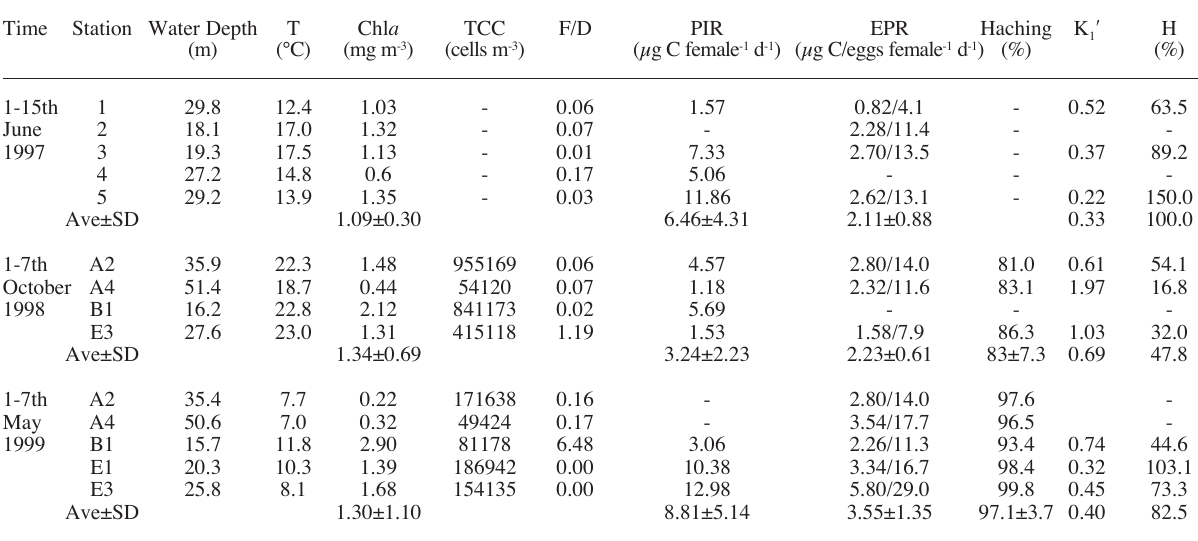
T ABLE 1.- Pigment ingestion rate, egg production rate, hatching success, egg production efficiency (K cus and environmental conditions at each station monitored during the three cruises in the Bohai Sea (Depth, temperature –T, Chlorophyll- a concentration-Chl a , total phytoplankton cell concentration-TCC, ratios between dinoflagellates and diatoms-F/D) Time Station Water